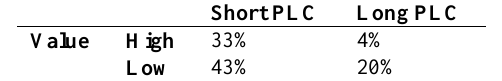
Table 2. Grid of responses in (rounded) percentages: product value and product life cycle Short PLC Long PLC Value High 33% 4% Low 43%